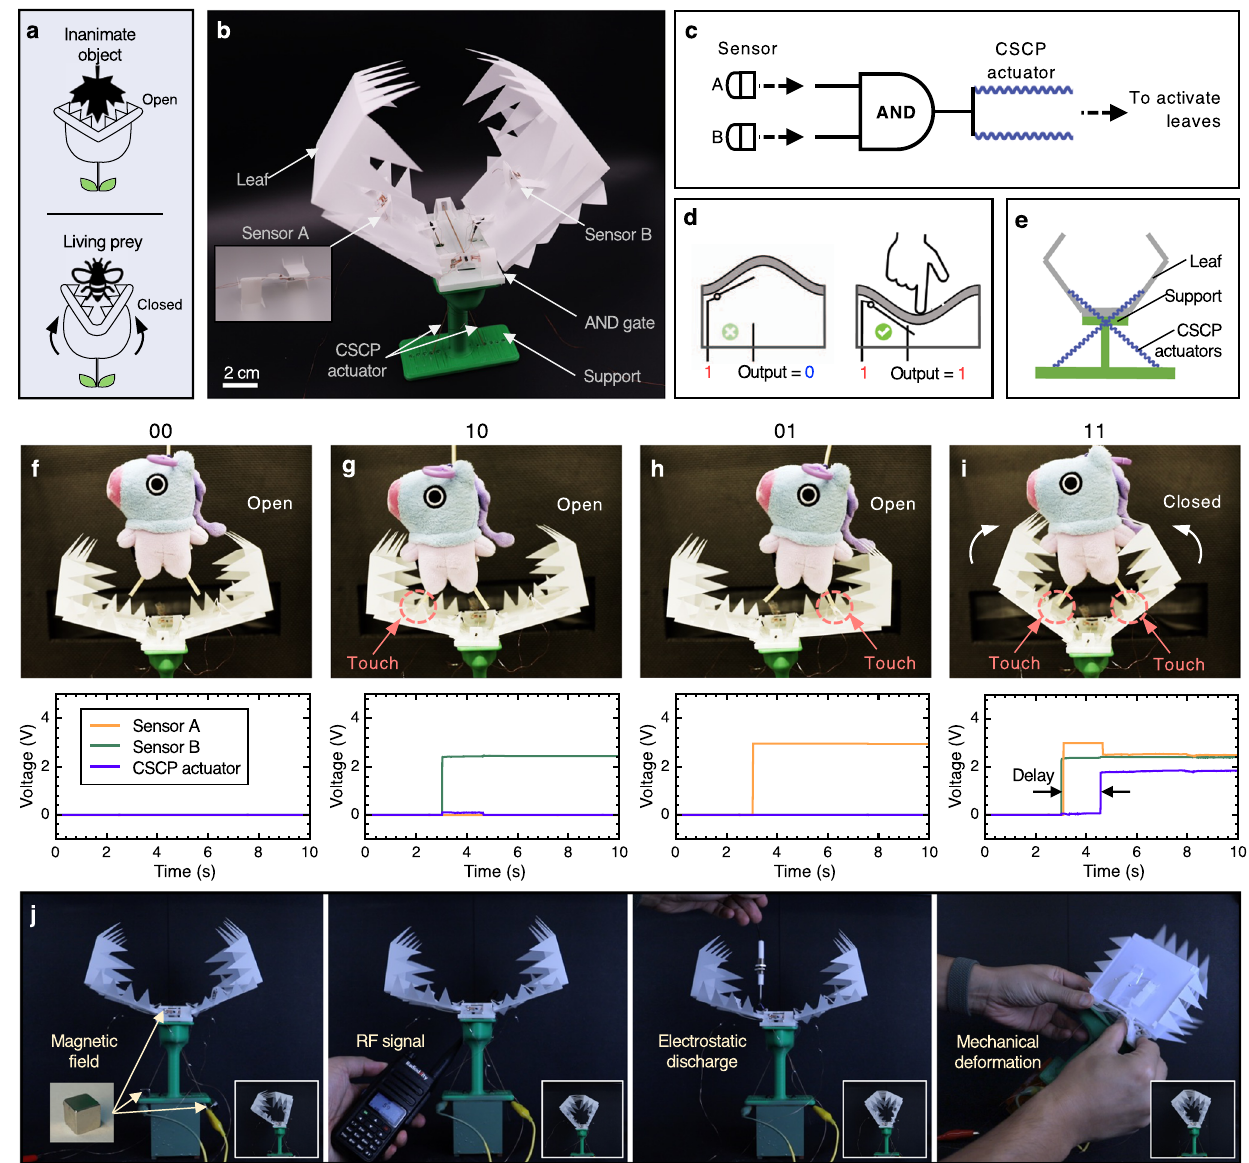
Fig. 5 | The origami fl ytrap-inspired prey-catching robot. a Venus fl ytrap can distinguishlivingpreysfrominanimatestimuliandcloseitsleavestocapturepreys. b Thedetailedstructureoftherobotwithlabels. c Thesimpli fi edcircuitdiagramof the robot. Two touch sensors located on the leaves perceive external information and send thatinformationasavoltage signaltothe ANDgate; the output(voltage) of the gate,inturn, isused toindicatetheoperation of the CSCP actuatorsthat are used to changethe stateof the leaves. d The schematicof a touch sensor modi fi ed from a bistable switch. e The actuation system of the fl ytrap-inspired robot. Two CSCP actuatorsare attached to the two leaves, respectively, to supply actuation to close them. f – i Demonstration of a living `prey' capture. This robot would only